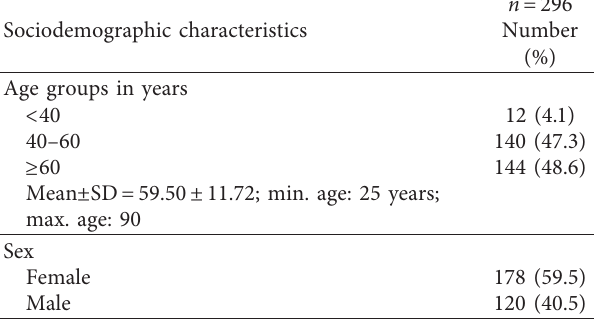
Table 1: Sociodemographic characteristics of